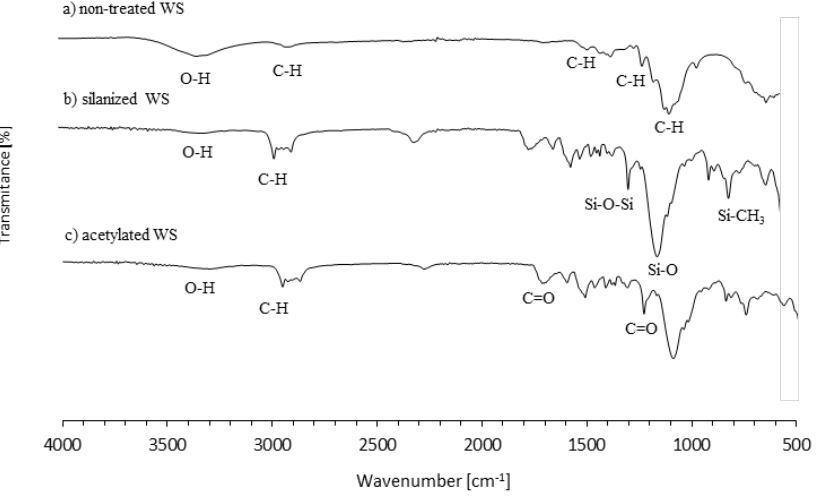
Figure 2. Fourier-transform infrared spectroscopy (FTIR) spectra of ( a ) non-treated WS, ( b ) silanized WS, and ( c ) acetylated WS.